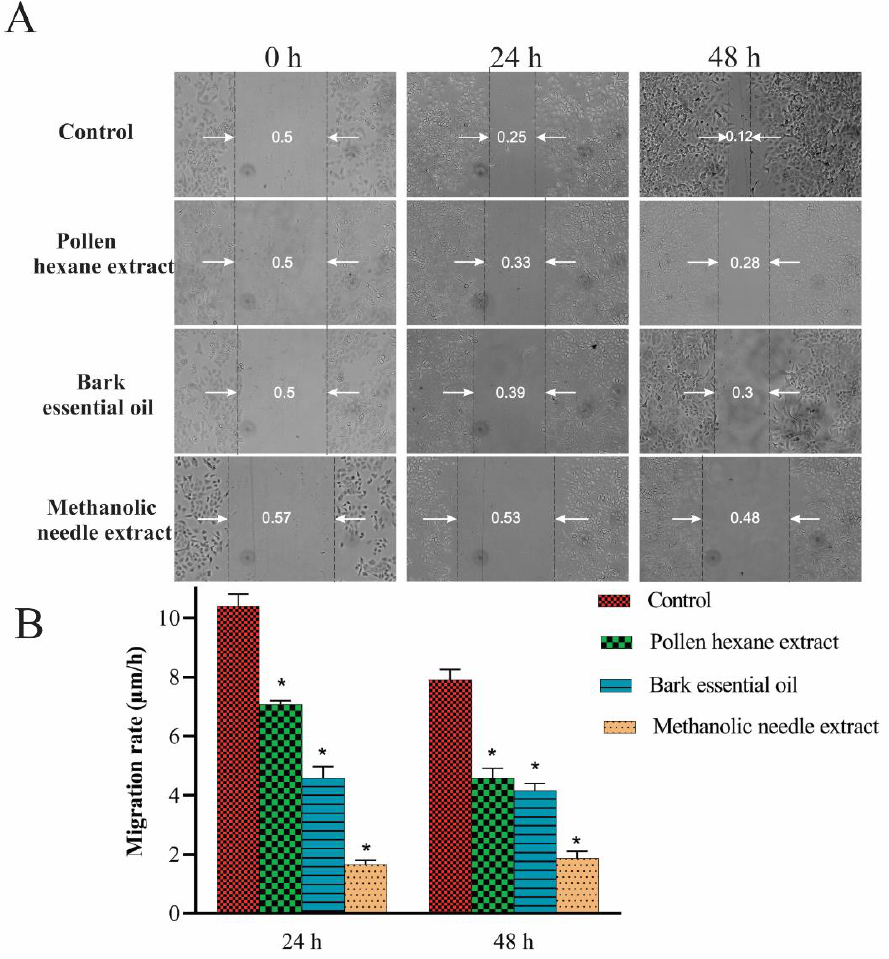
Figure 5. ( A ) Inhibition of A549 cell migration by Pinus eldarica extracts after 0, 24, and 48 h of treatment with bark essential oil (17.9 µ g/mL), pollen hexane extract (31.7 µ g/mL), and methanolic needle extract (0.3 µ g/mL). The distance between the two edges of the wound is shown in millimeters; ( B ) Migration rate ( µ m/h) of three extracts. Data are expressed as mean ± standard deviation (SD), representative of three independent experiments. * p < 0.05 vs. control.